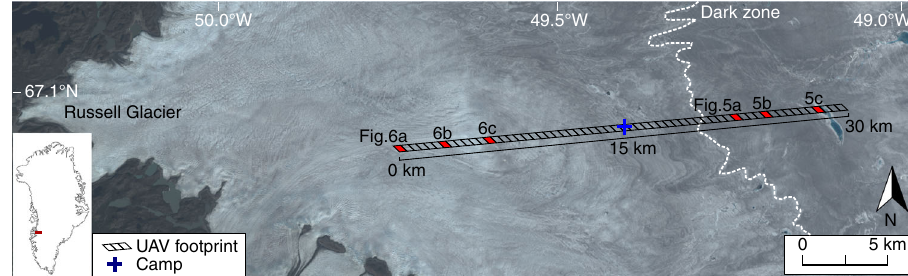
Fig. 1 Overview map showing location of UAV survey transect. The background is a Landsat 8 Operational Land Imager (OLI) true colour image of the Kangerlussuaq sector of the Greenland Ice Sheet from 6 August 2014. The transect was divided into sixty 0.25 km 2 segments for comparison with the MODIS albedo product, MOD10A1. High-resolution aerial imagery and surface classi fi cation of six segments (coloured red) are shown in Figs. 5 and